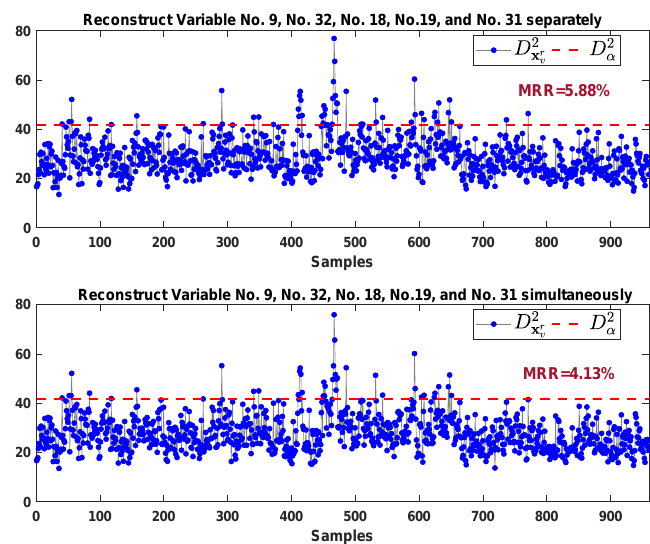
Figure 19. The fault detection results of reconstructed samples by estimating and replacing variable No.32, No.9, No.18, No.19, and No.31 (with larger VCkNN) for fault 11 of TE.